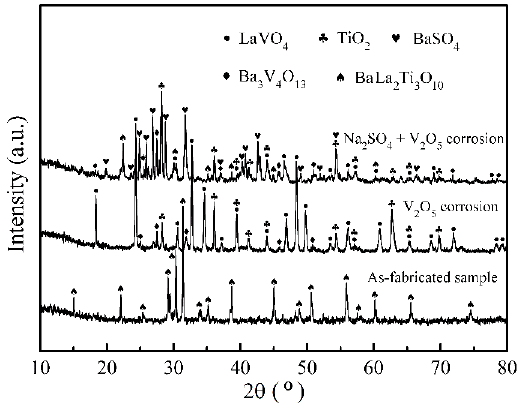
Figure 1. XRD patterns of BaLa 2 Ti 3 O 10 powders and the samples after hot corrosion in V 2 O 5 and Na 2 SO 4 + V 2 O 5 salts at 900 °C for 4 h.